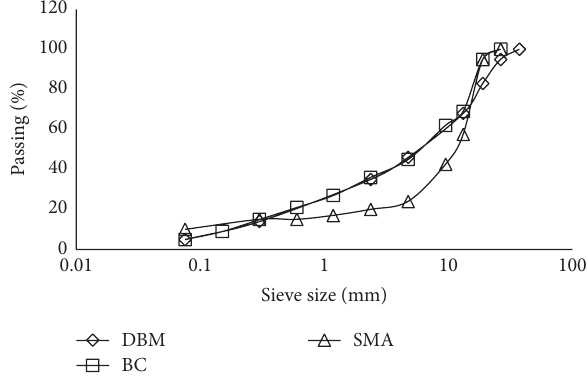
Figure 1: Aggregate gradation adopted in the